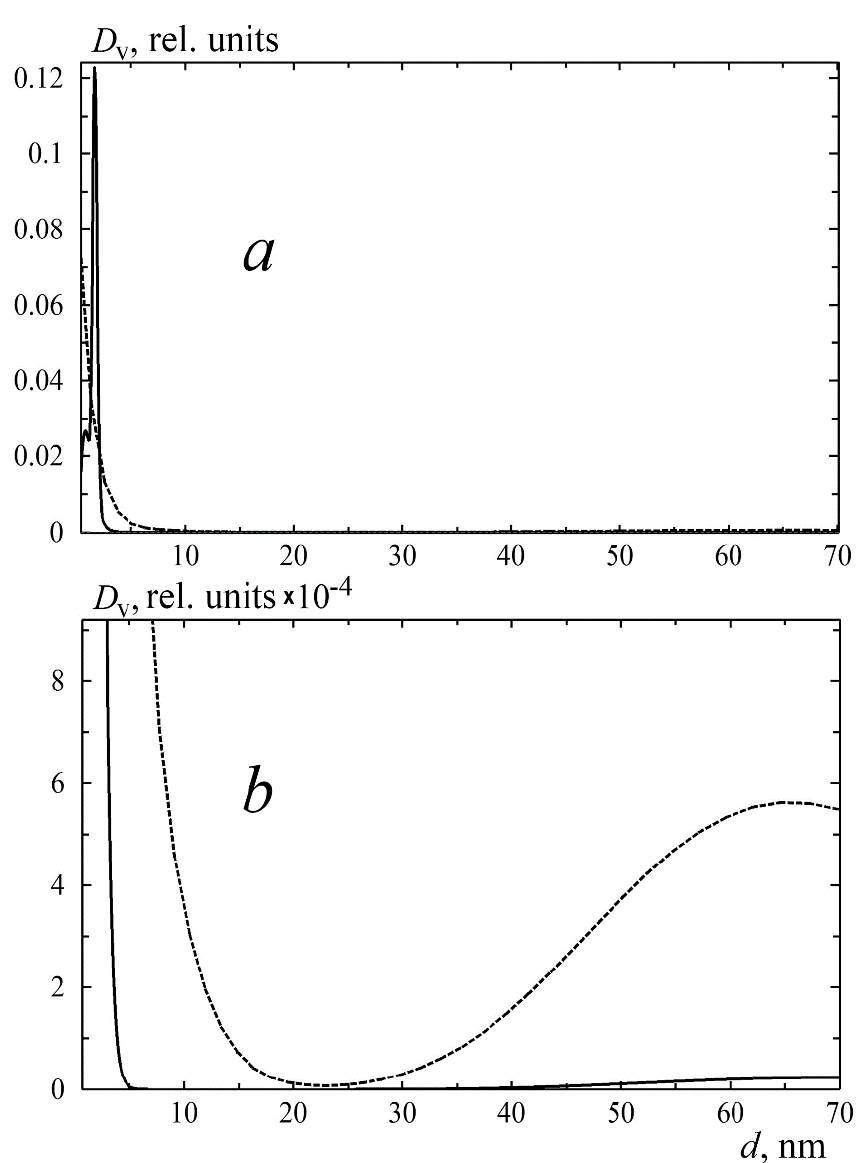
Figure 3. Volumetric distributions of inhomogeneities in the spherical approximation. The relative intensity of the distributions corresponds to the ratio of the scattering intensities. The data are shown in full scale ( a ), a large diameter region is enlarged ( b ). Dashed line—sc-CO 2 processed sample; solid line—initial PLGA granule.